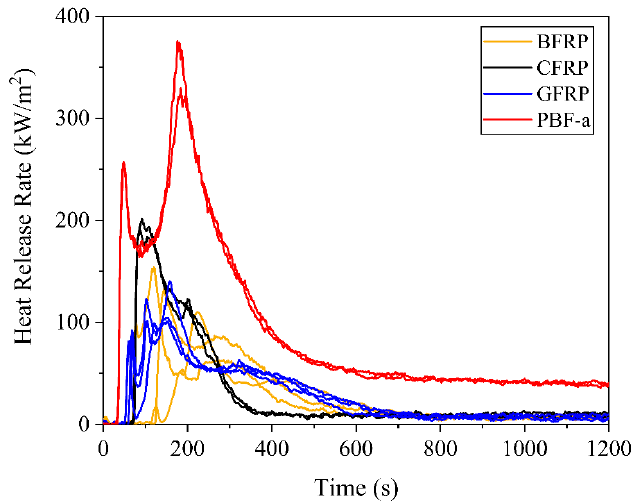
Figure 6. Heat release rate as a function of time for the three types of composites and non-reinforced